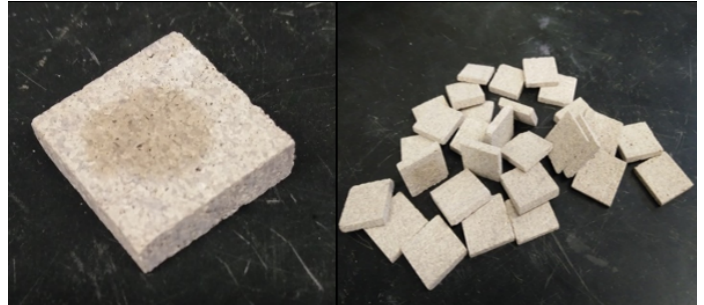
Figure 5. Indiana limestone (ILS) core sample slices are cleaned with methanol and toluene to remove possible existing salts, crude oil, and other deposits ( right ); core sample slices are in a hydrophilic (water-wet) state ( left ).